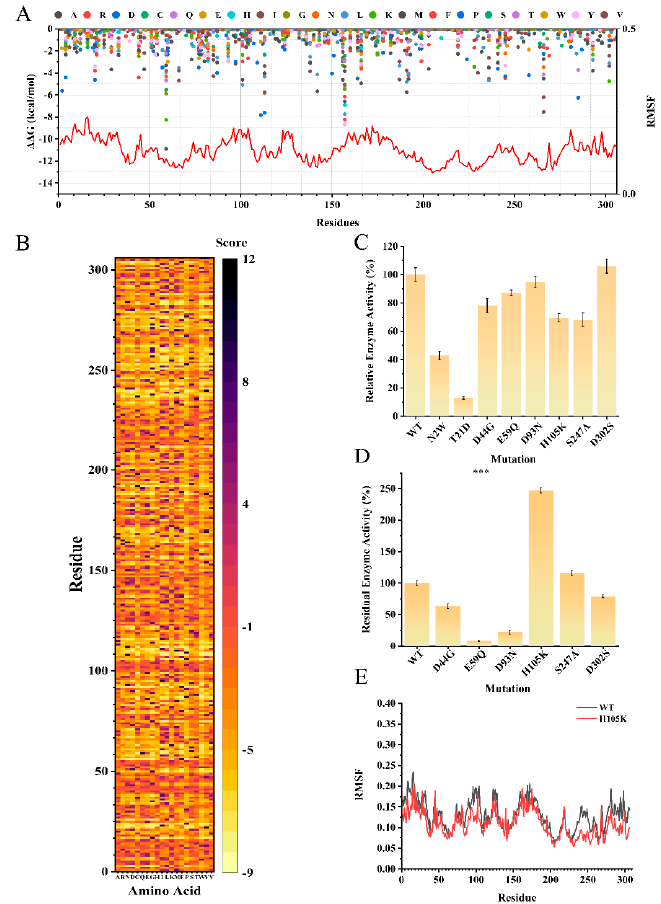
Figure 4. Computer-aided mutation prediction for increasing the thermostability. ( A ) The ddG value of the virtual saturation mutation and the RMSF of LreuglsA. The colored circles represent the energy change after virtual mutation, and the part where ddG is positive is not shown. The red line is the RMSF of LreuglsA, which indicates the side-chain flexibility of LreuglsA. ( B ) Evolvable residues based on the PSSM score to allow mutations. The more conserved amino acids scored higher at this position. ( C ) Enzyme activity of mutants reacted at 50 ◦ C for 5 min. The activities are presented as relative values observed for the mutants. ( D ) Enzyme activity of mutants after 72 h of incubation at 37 ◦ C. *** p < 0.005. ( E ) RMSF values of the side-chain atoms for the WT and H105K systems. The black line represents the outcome for the WT system, and the red line represents the outcome for the H105K system. The activities are presented as relative values observed for the mutants. Each experimental data point is the average of three independent experiments, and the error bars indicate standard